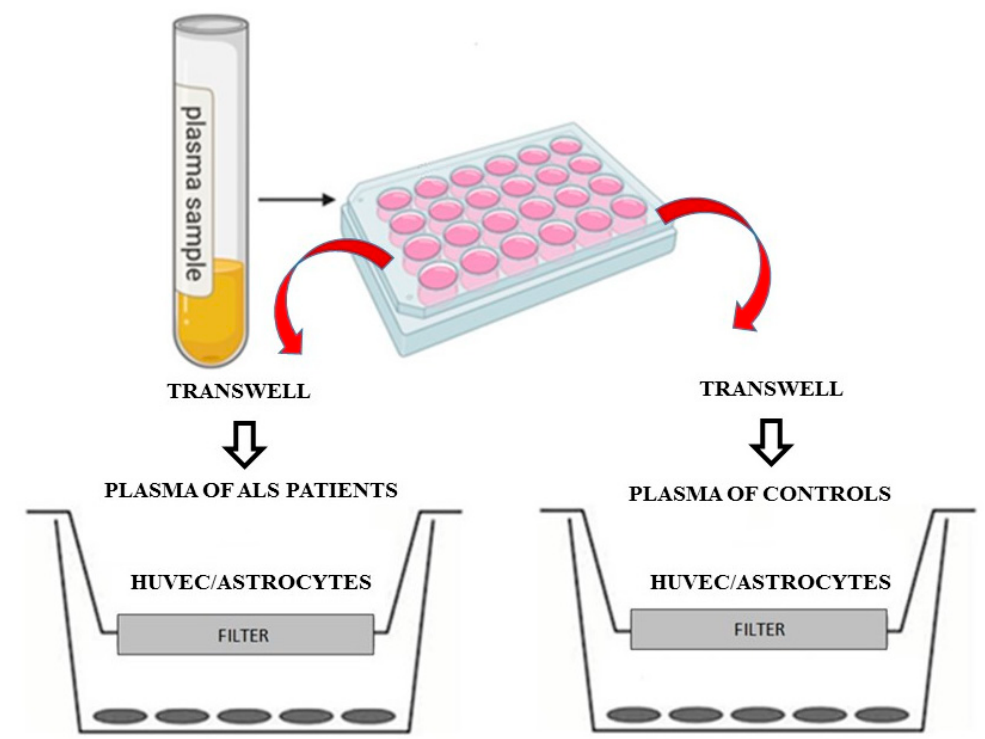
Figure 1. In vitro experimental protocol .